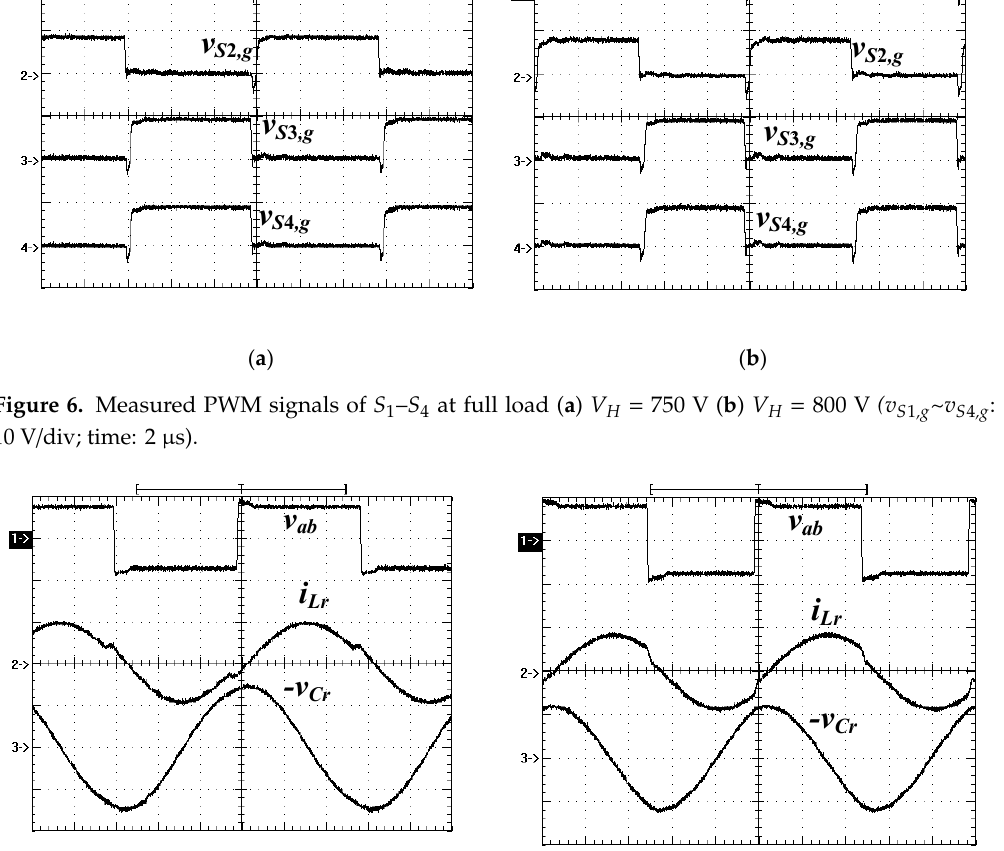
Figure 7. Measured results of v ab , i Lr and v Cr at full load ( a ) V H = 750 V ( b ) V H = 800 V (v ab : 500V/div; i Lr : 10 A/div; v Cr : 200 V/div; time: 2 μ s).